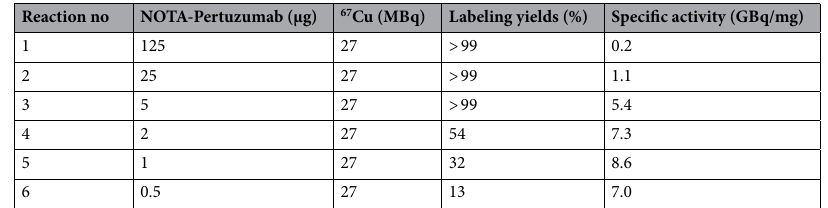
Table 1. Radiolabeling tests to obtain the highest achievable radiochemical yield and specific activity at the end of synthesis.